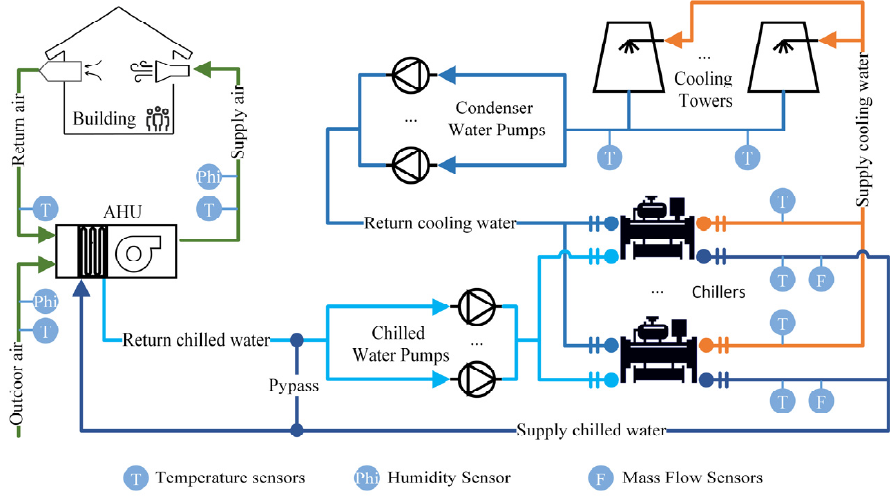
Figure 1. Diagram of a common HVAC system.